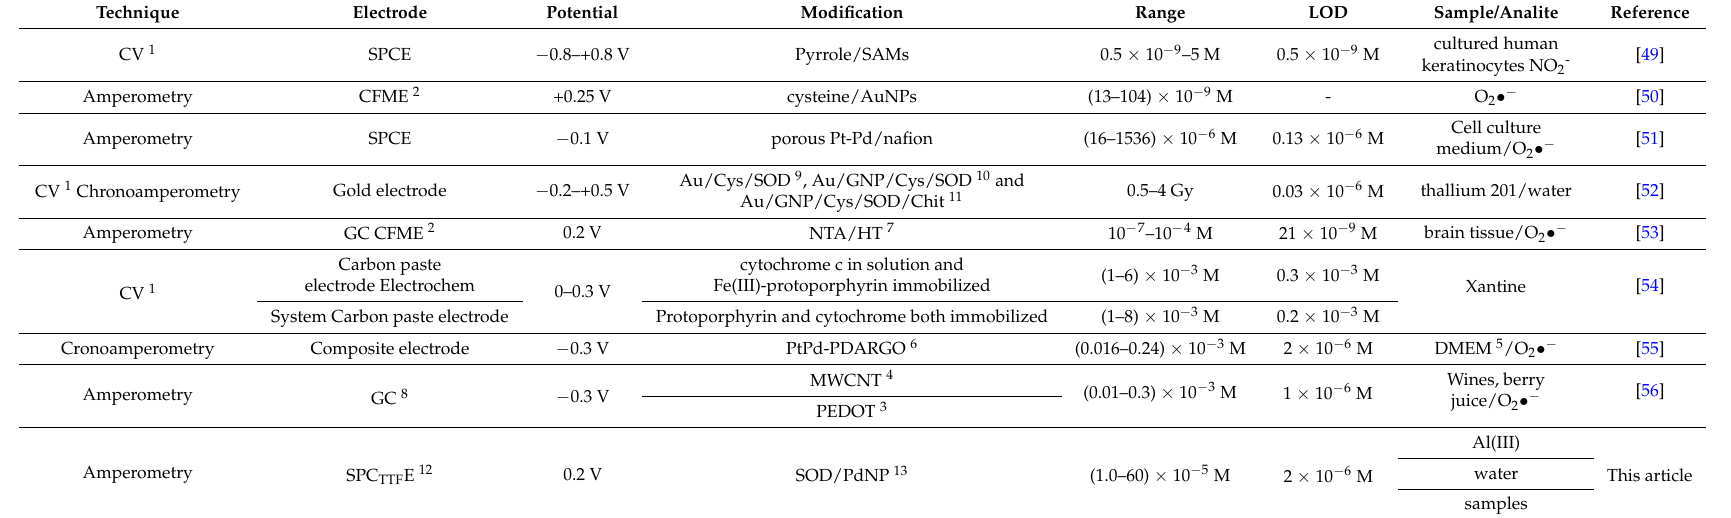
Table 1. SOD based biosensors applied to samples of biological